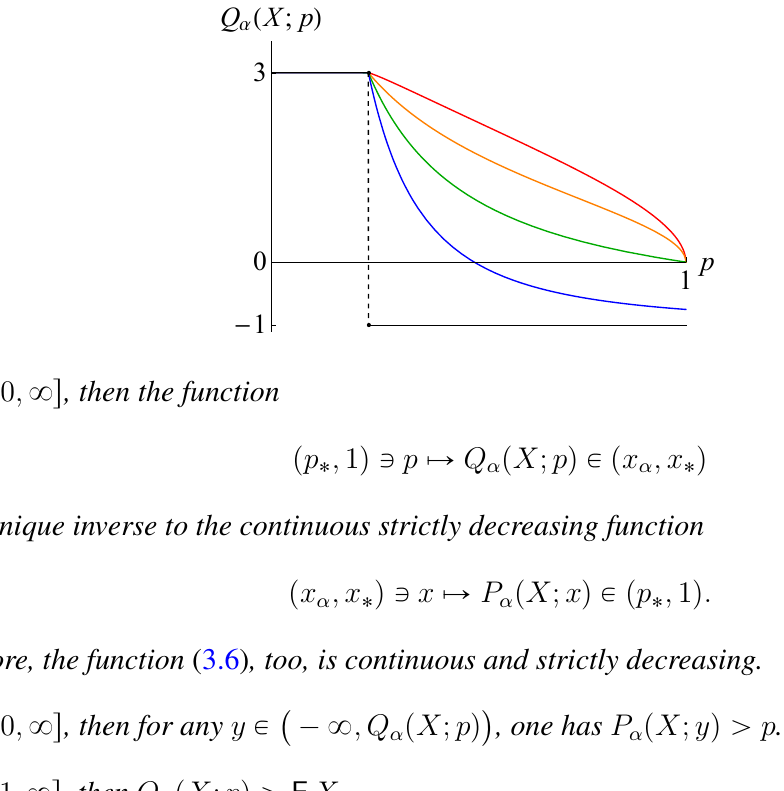
Figure 1. Illustration of Proposition 3.1 Q a H X ; p 3